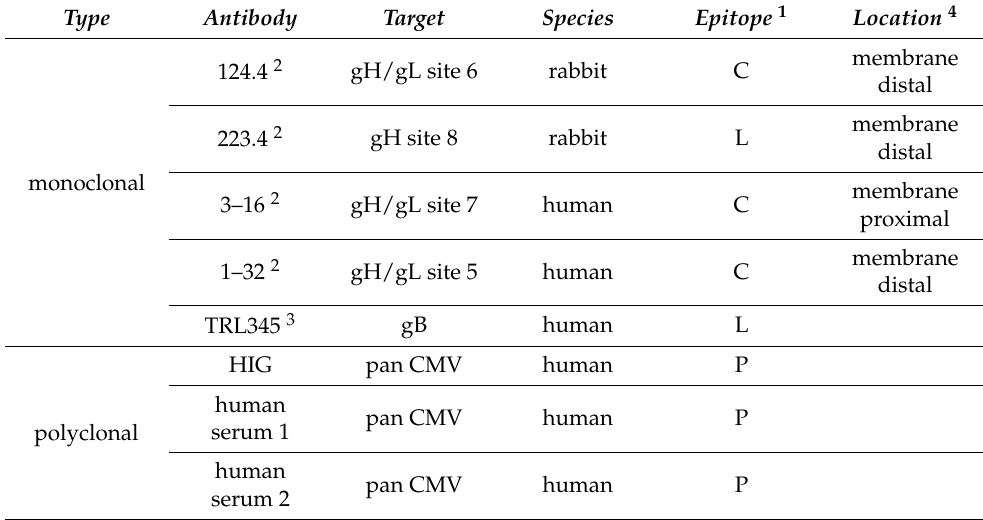
Table 1. Antibody